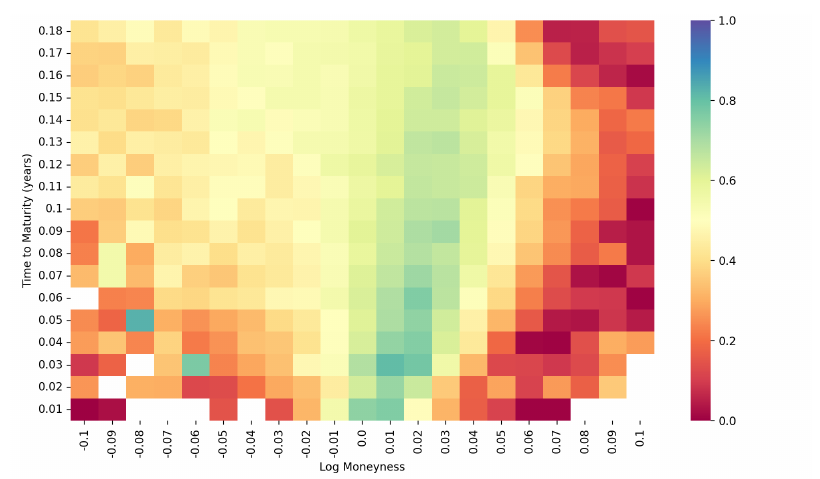
Figure 9. Heatmap of the S&P 500 data under the rBergomi model.